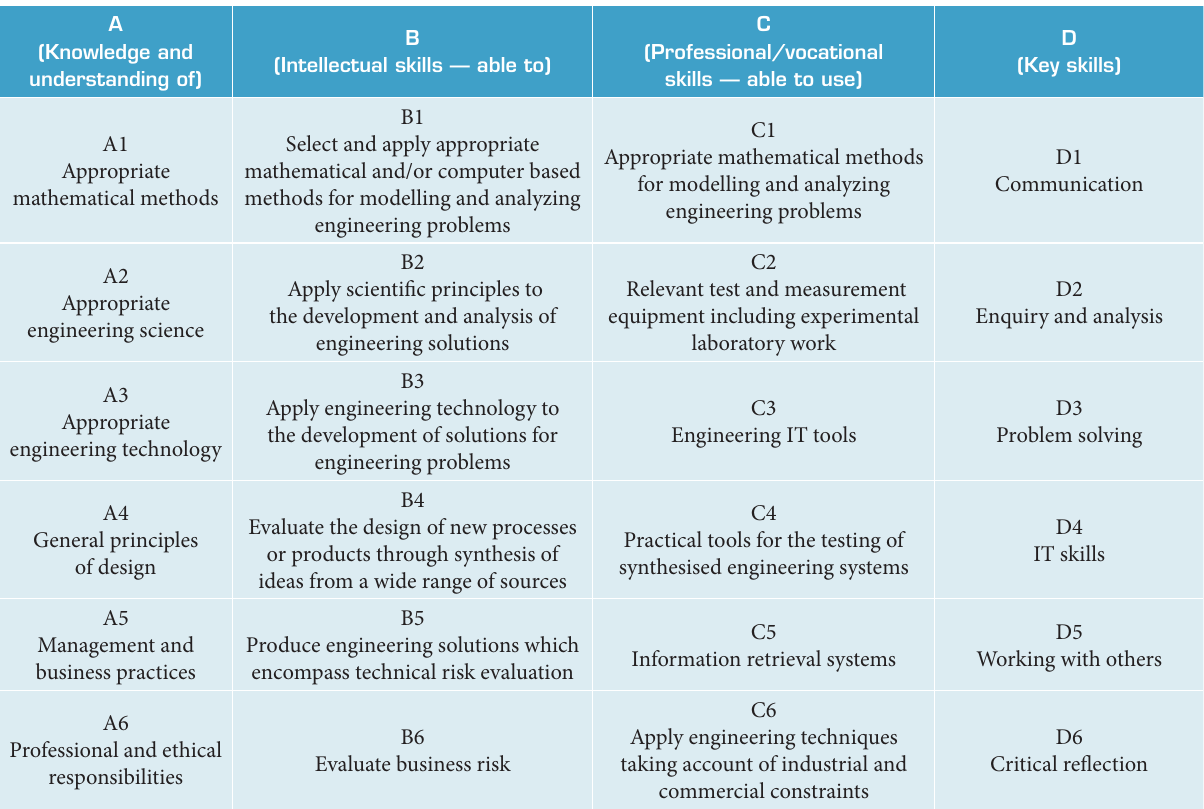
Table 1. Matrix of Intended Learning Outcomes (School of Engineering, University of South